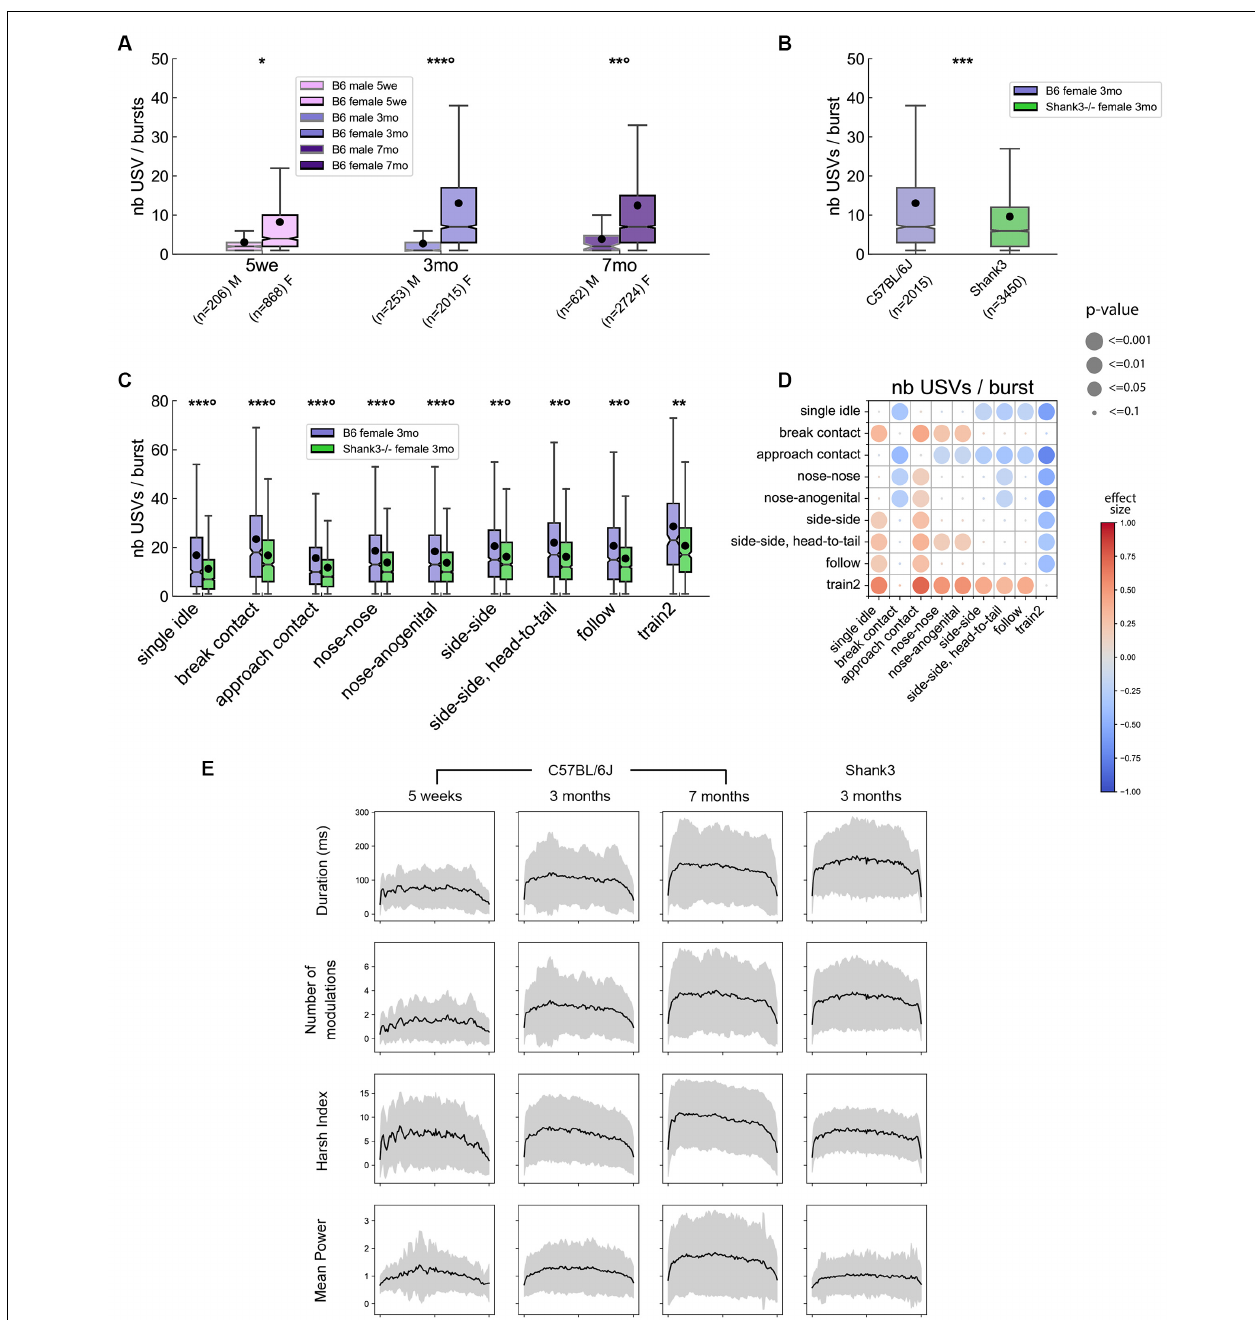
FIGURE 7 | Bursts characteristics in male and female pairs of B6 mice and in Shank3 − / − female mice. (A) Comparison of the number of USVs per burst between B6 males and females at 5 weeks, 3 months and 7 months of age (Linear Mixed Model with sex as fixed factor and pair as random factor). (B) Comparison of the number of USVs per burst between B6 females and Shank3 − / − females aged 3 months (Linear Mixed Model with genotype as fixed factor and pair as random factor). (C) Comparison of the number of USVs per burst between B6 females and Shank3 − / − females aged 3 months across the different contexts of emission (Linear Mixed Model with sex as fixed factor and pair as random factor). ns: not significant, uncorrected p -values: * p < 0.05, ** p < 0.01, ∗∗∗ p < 0.001; p -values followed by ◦ survived a correction for multiple testing ( A : age classes, B : no correction, C : number of behavioral contexts). (D) Comparison of the number of USVs per burst emitted by 3 months old B6 females between the different contexts of emission (Linear Mixed Models with context as fixed factor and pair as random factor). Blue colors indicate that the number of USVs per burst given during y-event is lower than the number of USVs per burst given in x-event; red colors indicate that the number of USVs per burst given during y-event is higher than the number of USVs per burst given in x-event; the effect size is represented by the color scale while the significance levels are represented by the size of the circles. (E) Evolution of acoustic characteristics of USVs (duration, frequency modulations, harsh index, mean power) according to their position within a burst in B6 females aged 5 weeks, 3 months, and 7 months as well as in Shank3 − / − female mice aged 3 months.